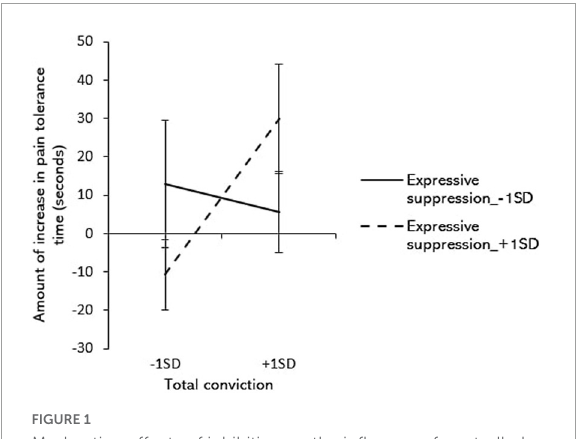
FIGURE1 Moderating effects of inhibition on the influence of controlled and automatic cognitions on safety behaviors. Error bars are standard